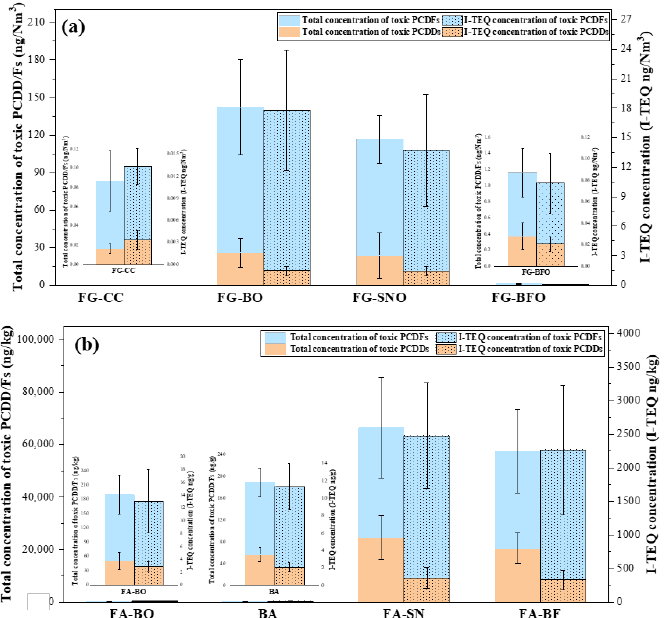
Figure 2. Total concentrations and I-TEQ concentrations of toxic PCDDs, PCDFs and PCDD/Fs in FG ( a ) and FA/BA ( b ) from the leather-waste-incineration process.